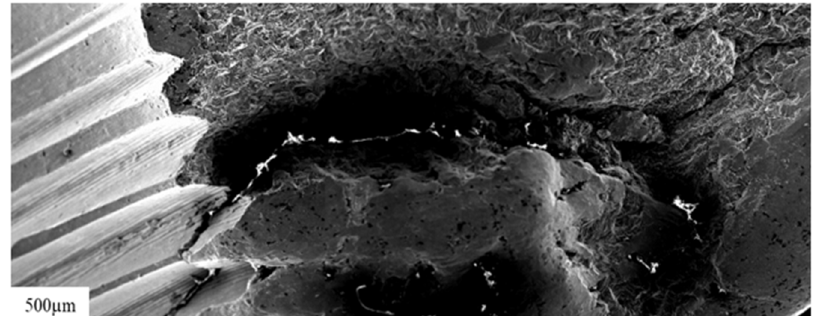
Figure 7. Crack propagation initiated in the center part of the thread.